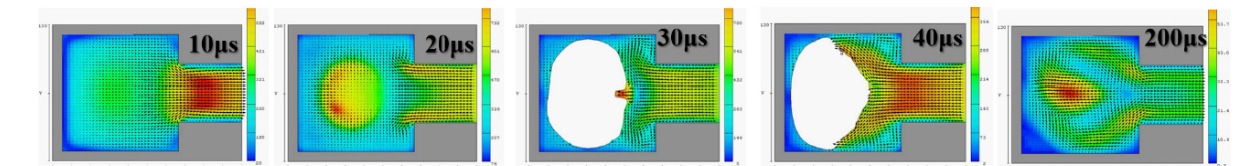
Figure 4. Calculate and simulate the injection of water in a single-channel injection chamber with a nozzle diameter of 60 µ m and a thickness of 50 µ m, at an operating frequency of 5 KHz, in the X-Y two-dimensional cross-sectional view, at 10, 20, 30, 40 and 200 µ s.